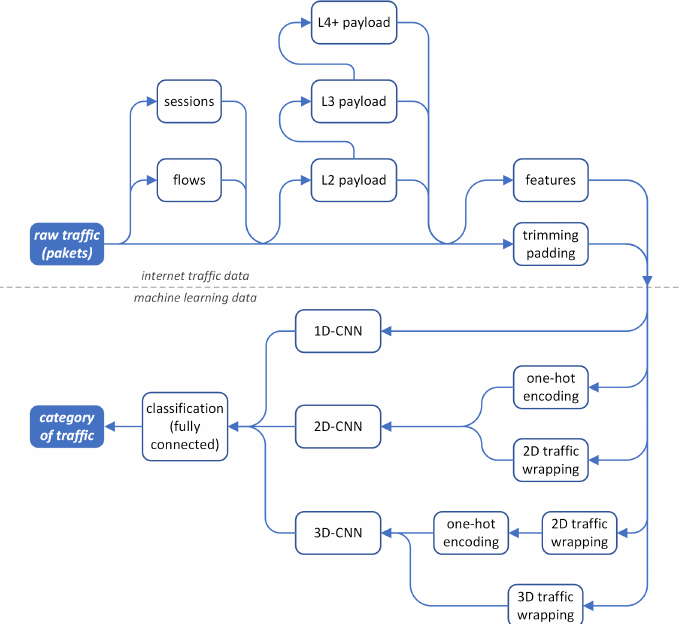
Figure 2. Workflow diagram of network traffic classification using deep convolutional neural networks with various data transformation